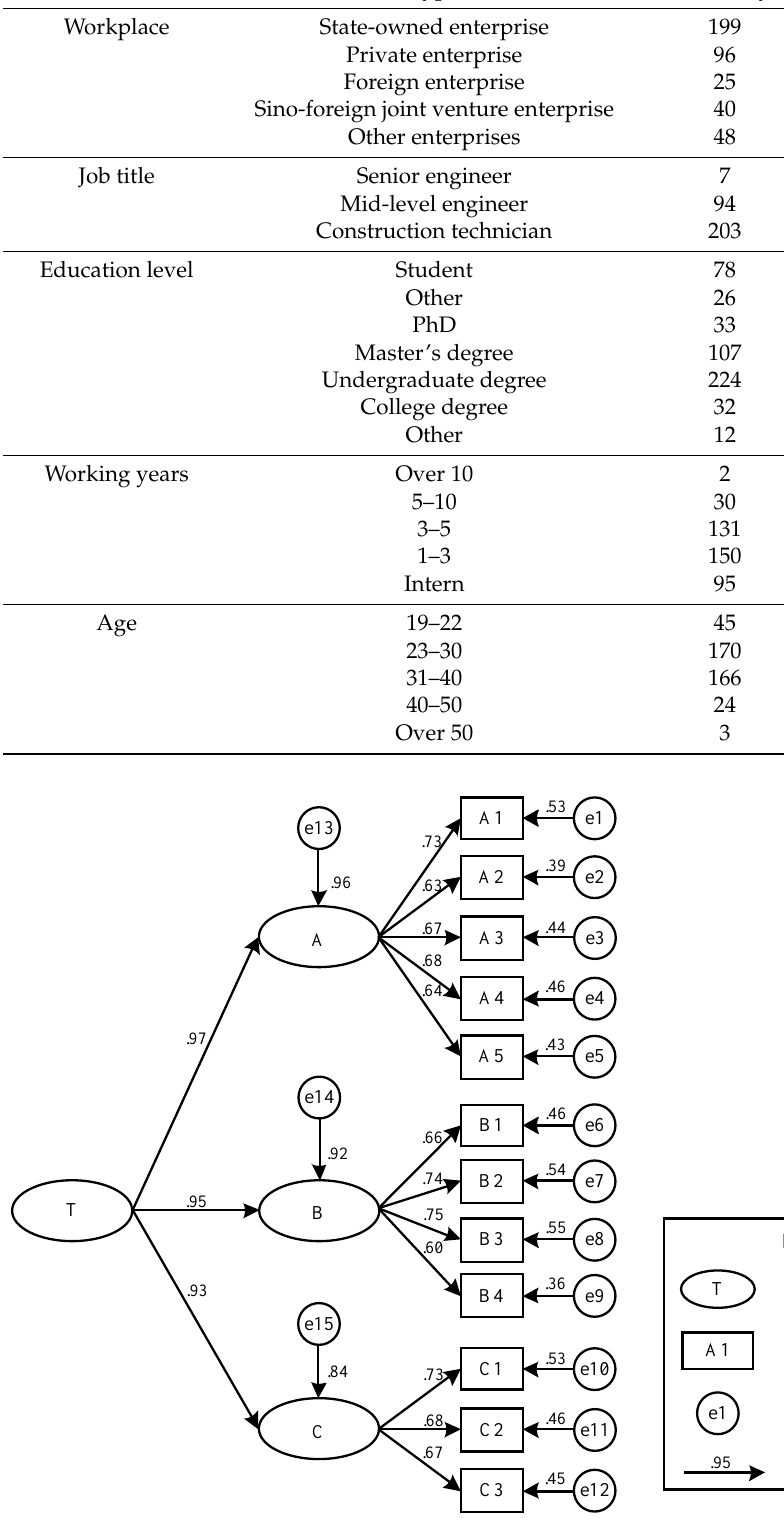
Figure 2. Second-order confirmatory factor analysis structural model diagram.